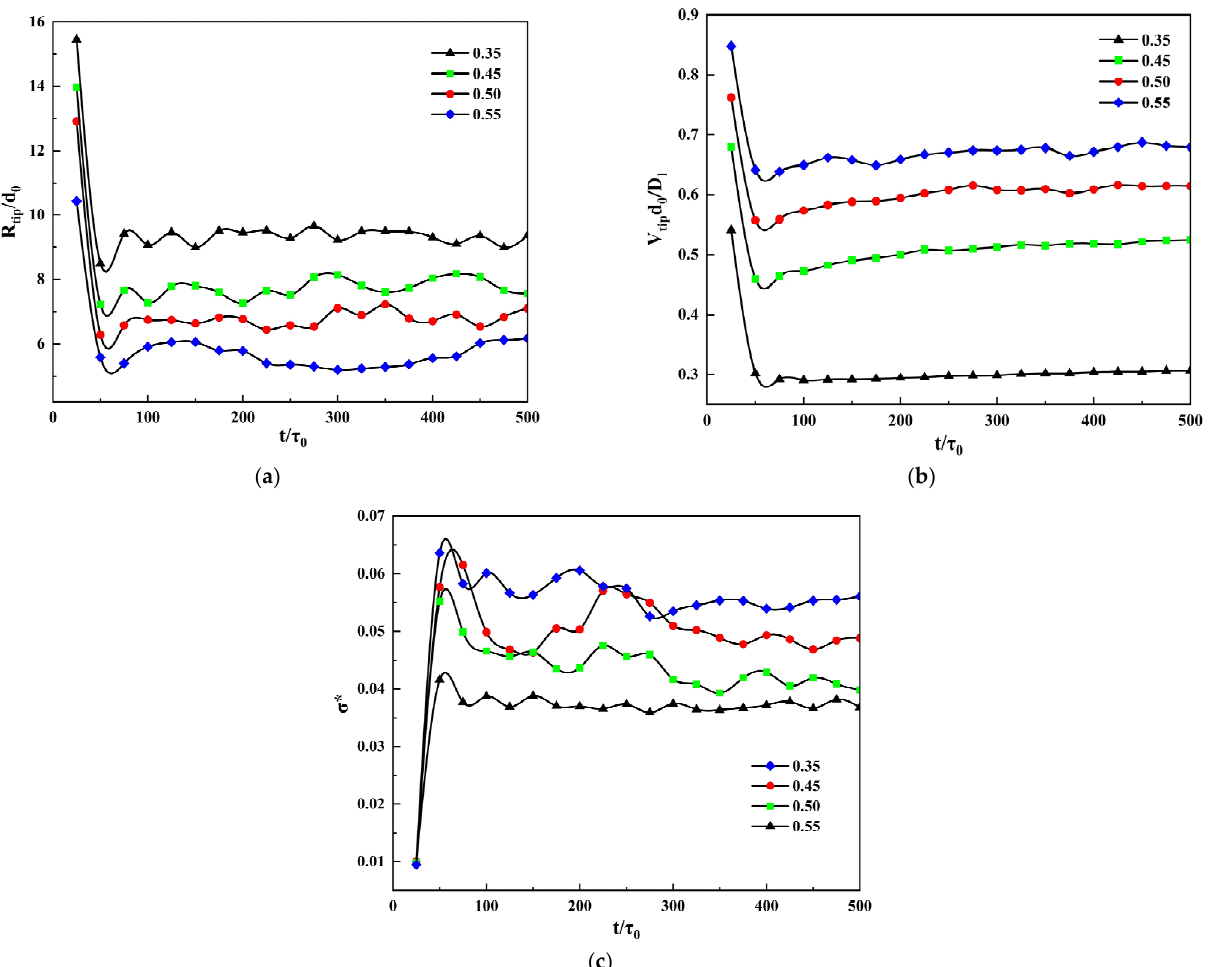
Figure 4. The curve of dendrite tip parameters changes with simulation time under different supersaturation. ( a ) Tip velocity; ( b ) Tip radius; ( c ) Steady-state coefficient.